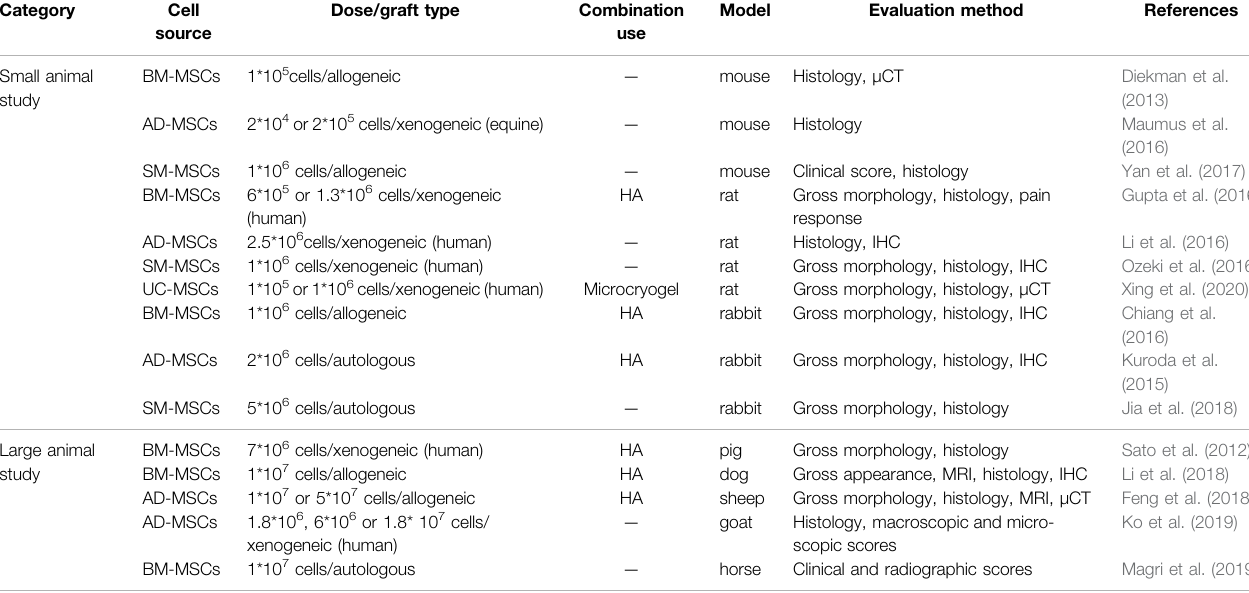
TABLE 2 | Animal models using IA injection of MSCs for treating OA.